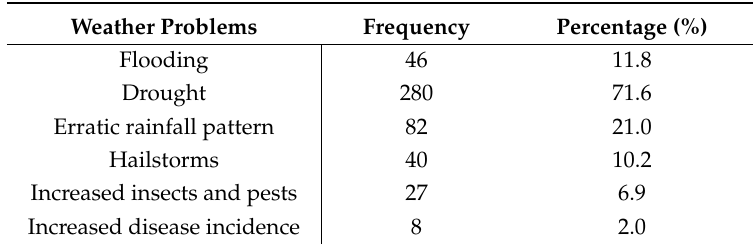
Table 4. Farmers’ perception of problems attributed to climate change ( n =